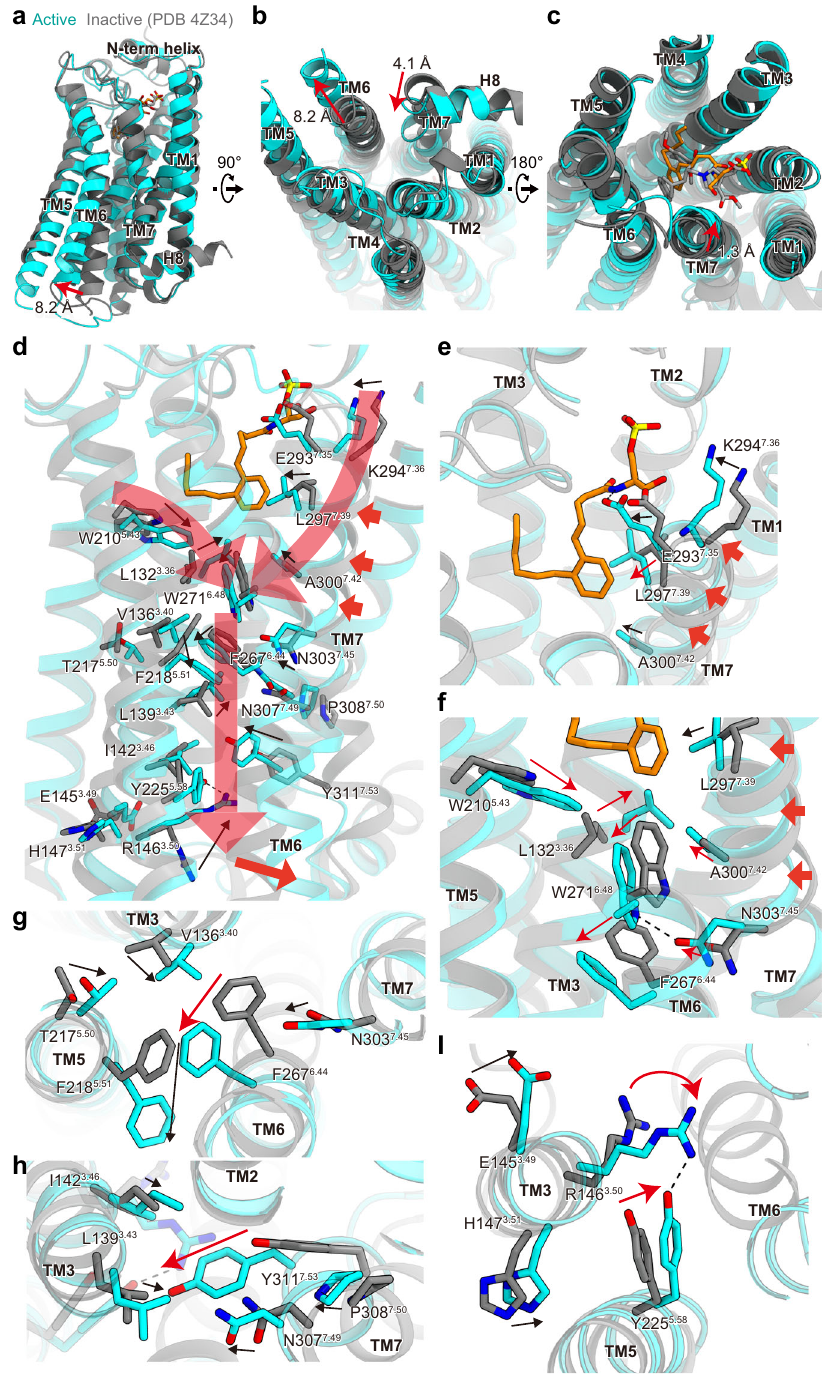
Fig. 4 | Comparison of the agonist- and antagonist-bound LPA 1 structures. Superimposition of the agonist- and antagonist-bound LPA 1 structures, colored cyan and gray (PDB 4Z34), respectively, viewed from the membrane plane ( a ), the intracellularside( b ),andtheextracellularside( c ).D251inTM6andY311inTM7are shifted by about 8.2 and 4.1Å, respectively. d – f Structural changes of the